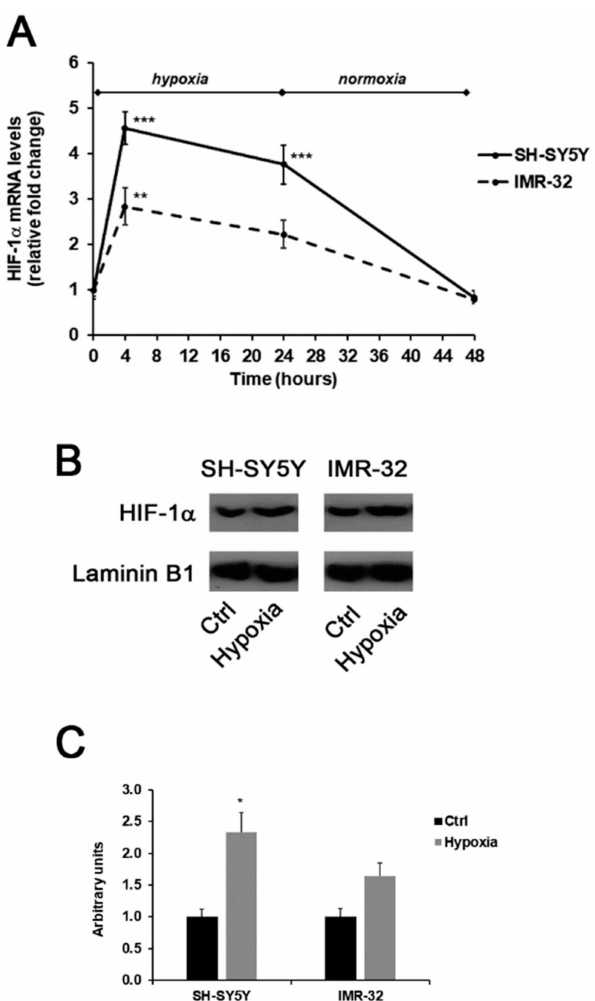
Figure 1. E ff ects of the exposure to hypoxia on the expression of HIF-1 α in SH-SY5Y and IMR-32 NB cells. After incubation times, cells were harvested and used for the analysis of HIF-1 α mRNA levels by Real-Time PCR ( A ); the nuclear content of HIF-1 α protein in cells incubated for 4 h in hypoxic condition was assessed by Western blotting ( B ) and subsequent densitometric analysis ( C ). Data are expressed as mean ± SEM. * p < 0.05, ** p < 0.01 and *** p < 0.001 significant di ff erences in comparison to